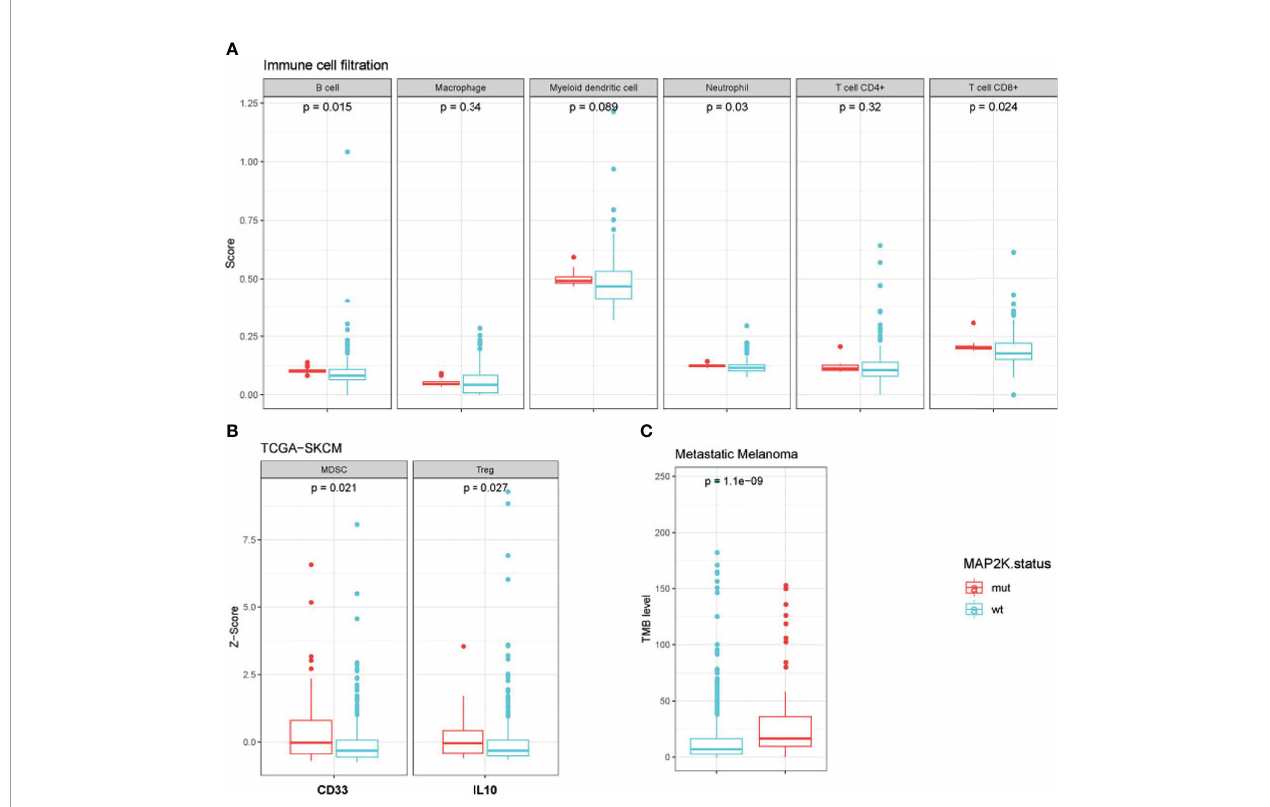
FIGURE 4 | Immunological microenvironment of MAP2K1/2 -mutated melanoma. Boxplot comparing immune cell fi ltration between mutated and wild-type MAP2K1/2 subgroup in metastatic melanoma cohort (A) , the expression of immune-related genes between the mutated and wild-type MAP2K1/2 subgroups in TCGA-SKCM cohort (B) , and tumour mutational level between mutated and wild-type MAP2K1/2 subgroup in metastatic melanoma cohort (C)